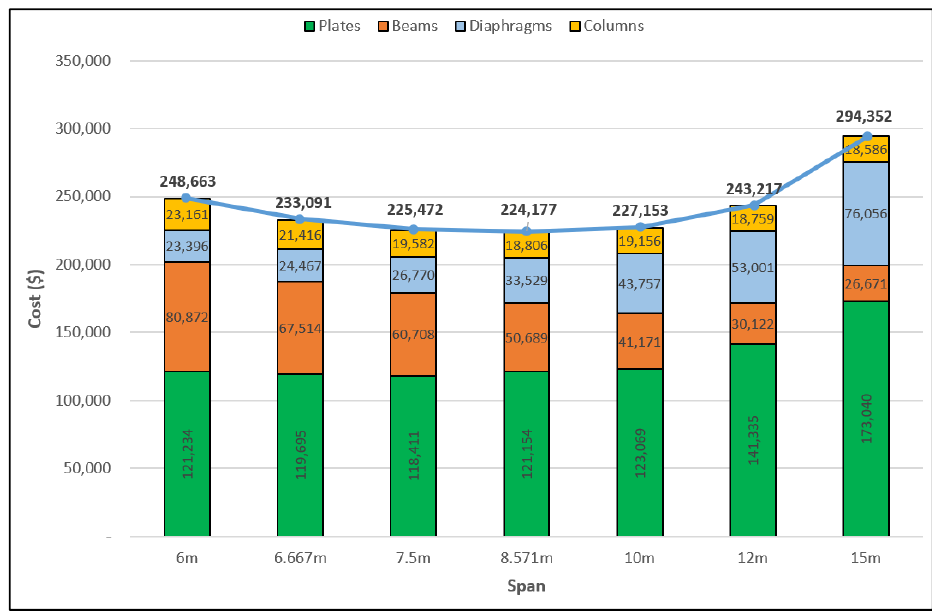
Figure 23. Cost components of the optimum designs achieved at different transverse spans for the V-type folded plate roof building.